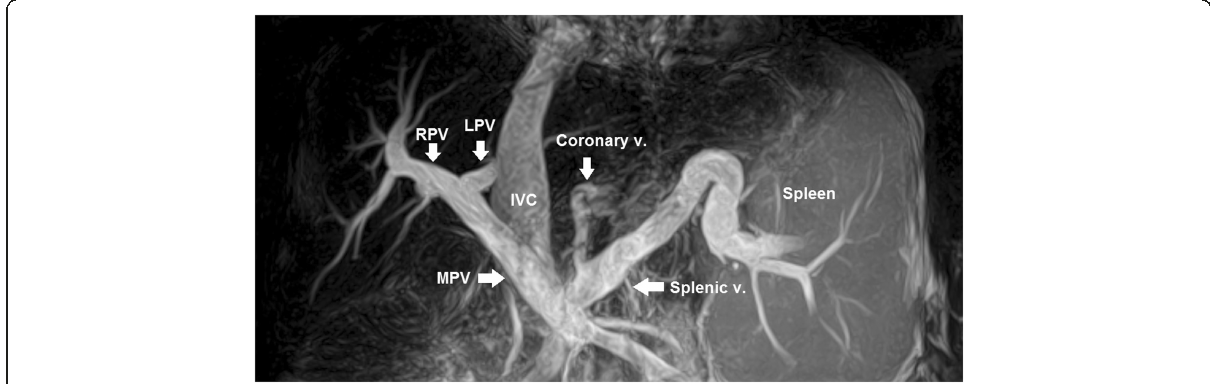
Fig. 3 Portal hypertension. Coronal maximum intensity projection image from a non-contrast MR portography using T-SLIP technique showing dilated portal and splenic veins with sizeable patent coronary vein denoting portal hypertension. Splenomegaly is noted as well. The inevitable flow-related enhancement of intrahepatic segment of IVC obscures the part of left portal branch which requires further post-processing for removal. MPV, main portal vein; RPV, right portal vein; LPV, left portal vein; IVC, inferior vena cava